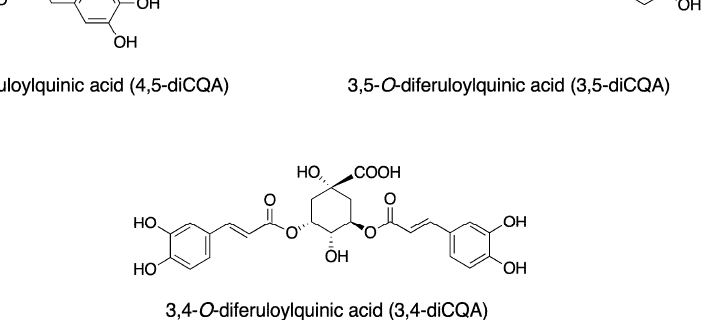
Figure 1. The chemical structure of chlorogenic acids.